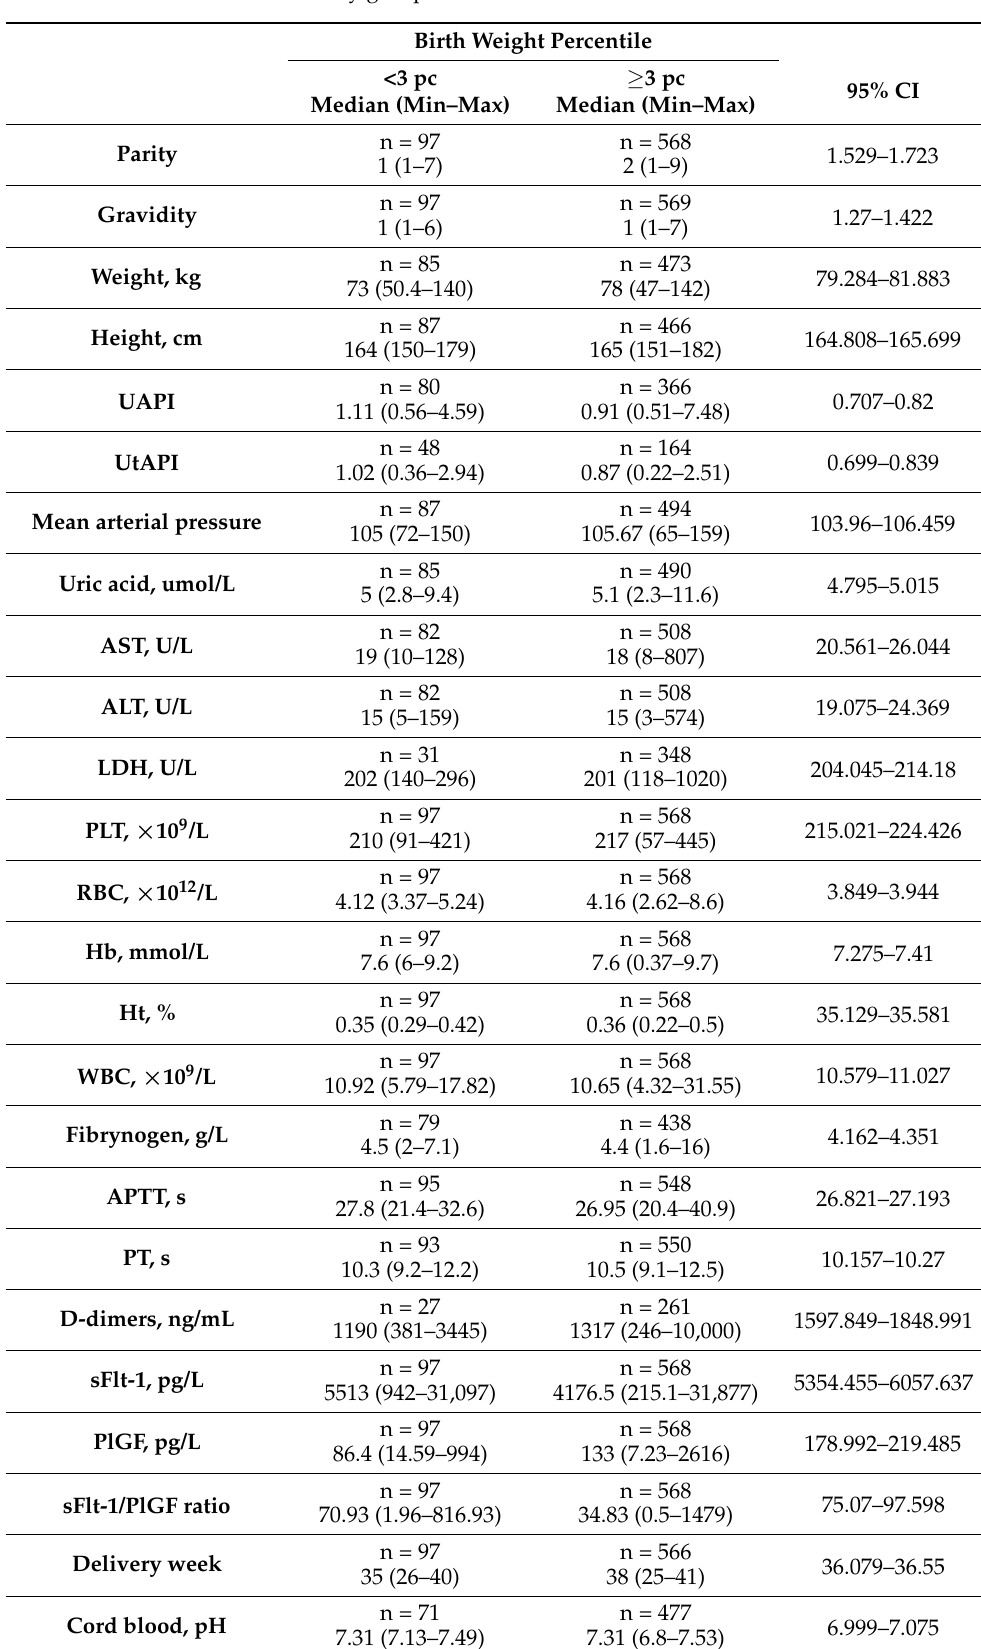
Table 1. Characteristics of the study